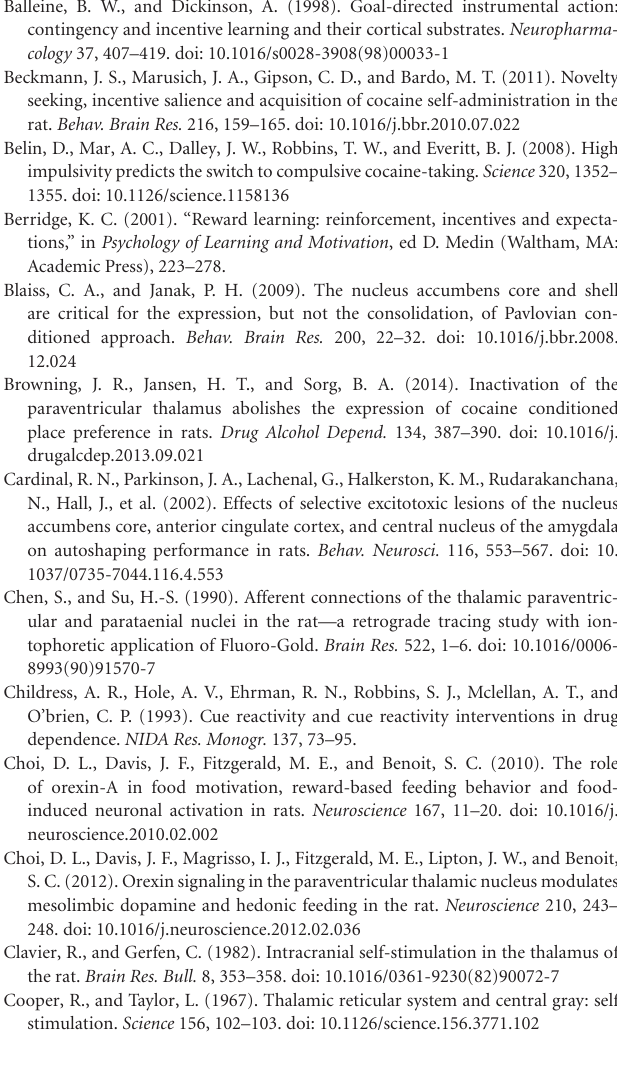
FIGURE 4 | Schematic illustrating afferents and efferents of interest in the PVT. This simplified schematic illustrates PVT afferents and efferents that are potentially involved in Pavlovian conditioned approach behavior. The solid green arrow represents sub-cortical dopamine inputs from the hypothalamus (Hyp). The dashed green line represents less dense dopaminergic input from the ventral tegmental